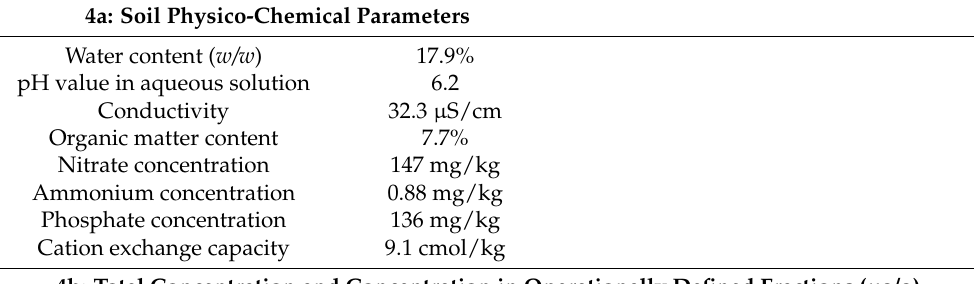
Table 4. Soil physico-chemical parameters and concentrations of